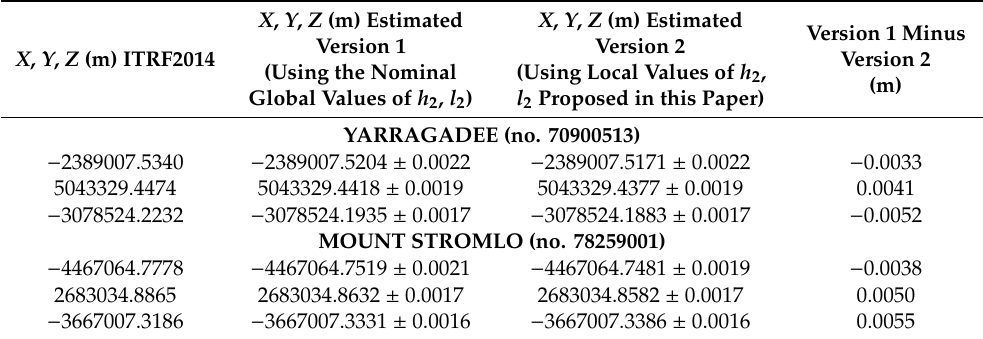
Table 2. The X , Y , Z coordinates of the Yarragadee and Mount Stromlo SLR stations estimated in two calculation